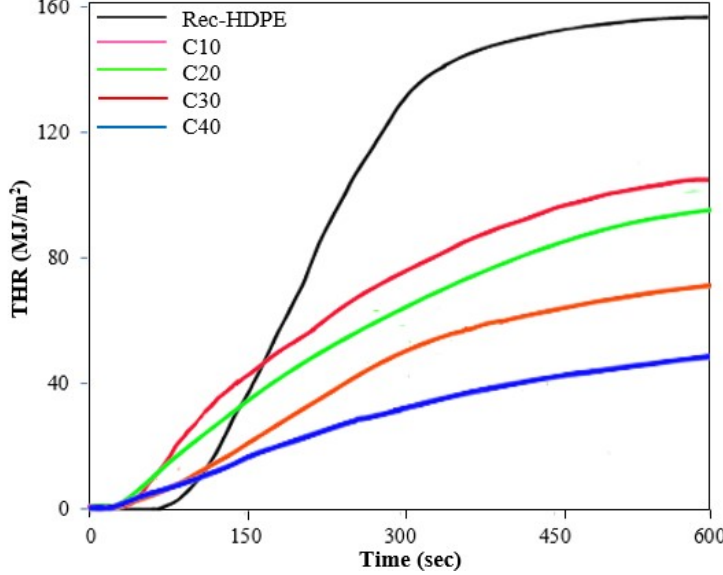
Figure 7. Total heat release rate of the recycled HDPE and composites.